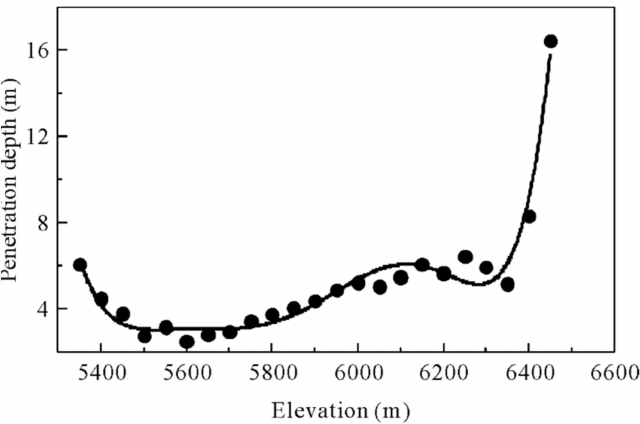
Figure A7. The relationship of penetration depth and elevation on the ZK ice field.